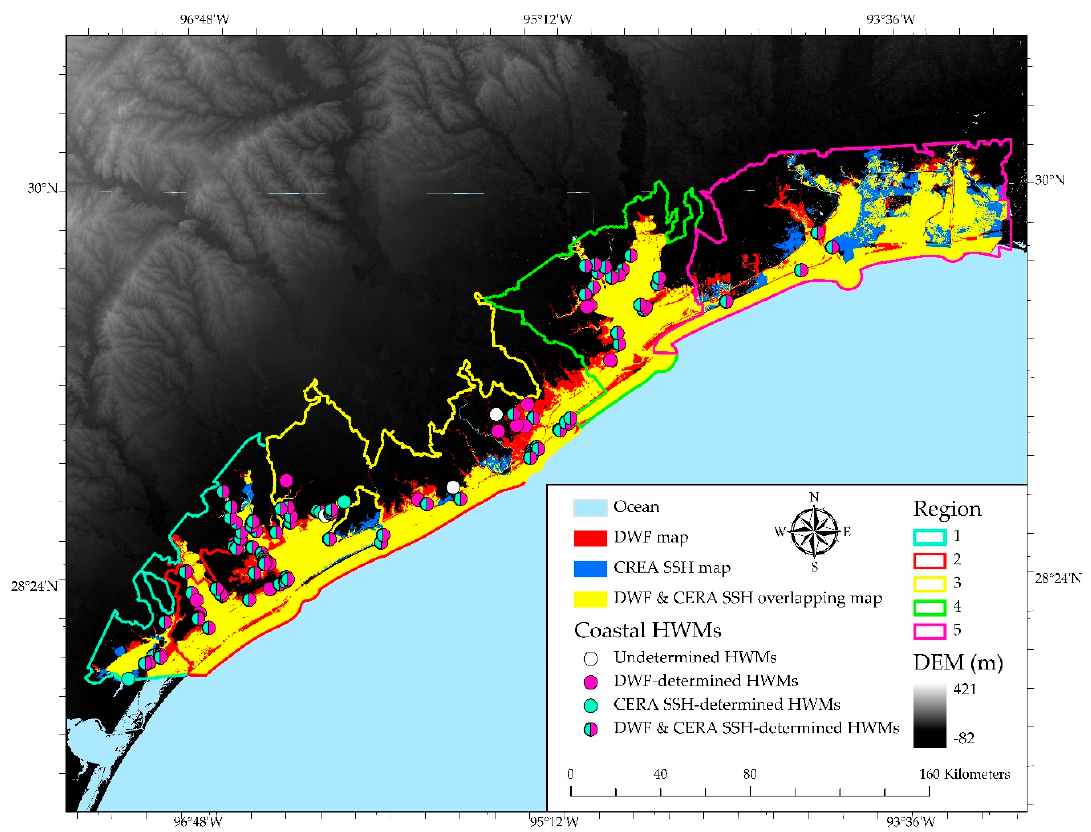
Figure 10. DWF map, CERA SSH product, and high-water-marks (HWMs). Table 2. Quantitative comparative analysis of DWF map and CERA SSH product.